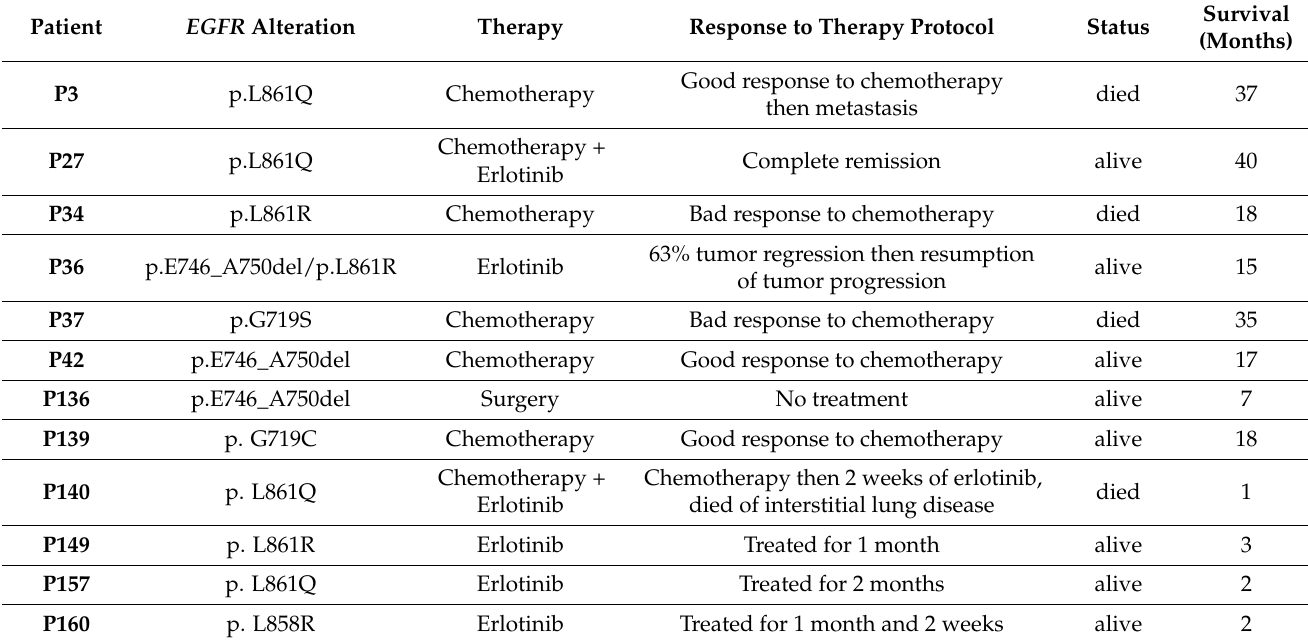
Table 4. Treatment response and survival of patients carrying EGFR